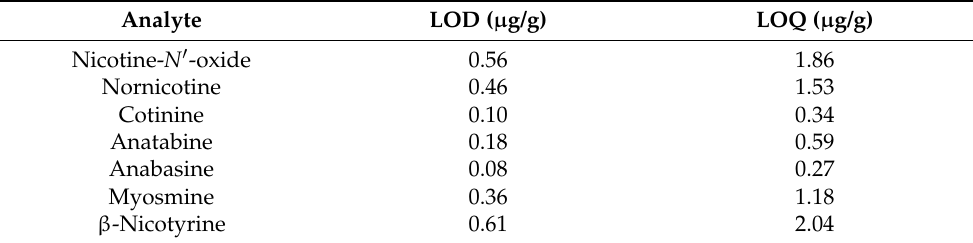
Table 3. LOD and LOQ for all analytes in µ g/g.